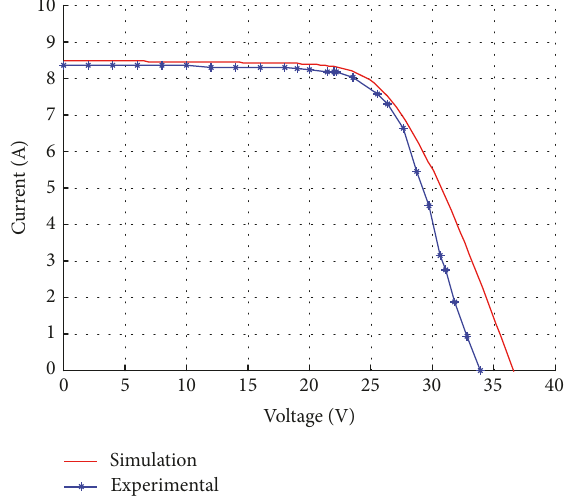
Figure 19: The 𝐼 - 𝑉 characteristics of PFV ALTIUS